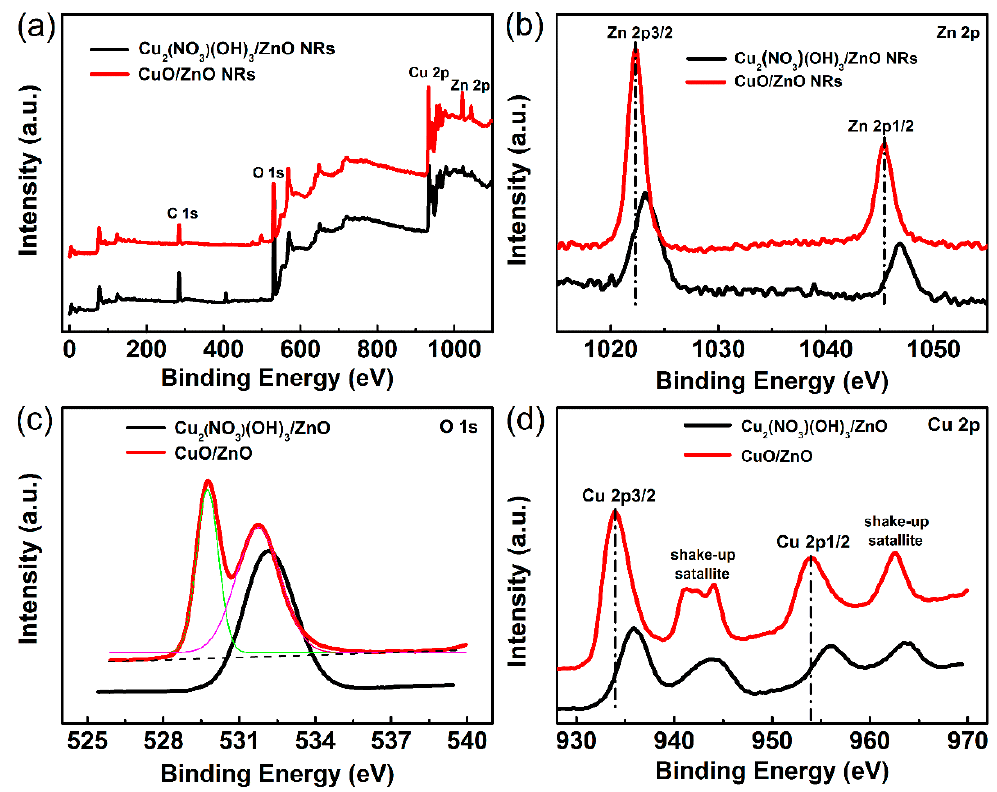
Figure 5. ( a ) The full survey XPS spectra, high resolution XPS spectra of ( b ) Zn 2p, ( c ) O 1s and ( d ) Cu 2p of the Cu 2 (NO 3 )(OH) 3 /ZnO and 300 °C annealing CuO/ZnO heterojunction NRs.